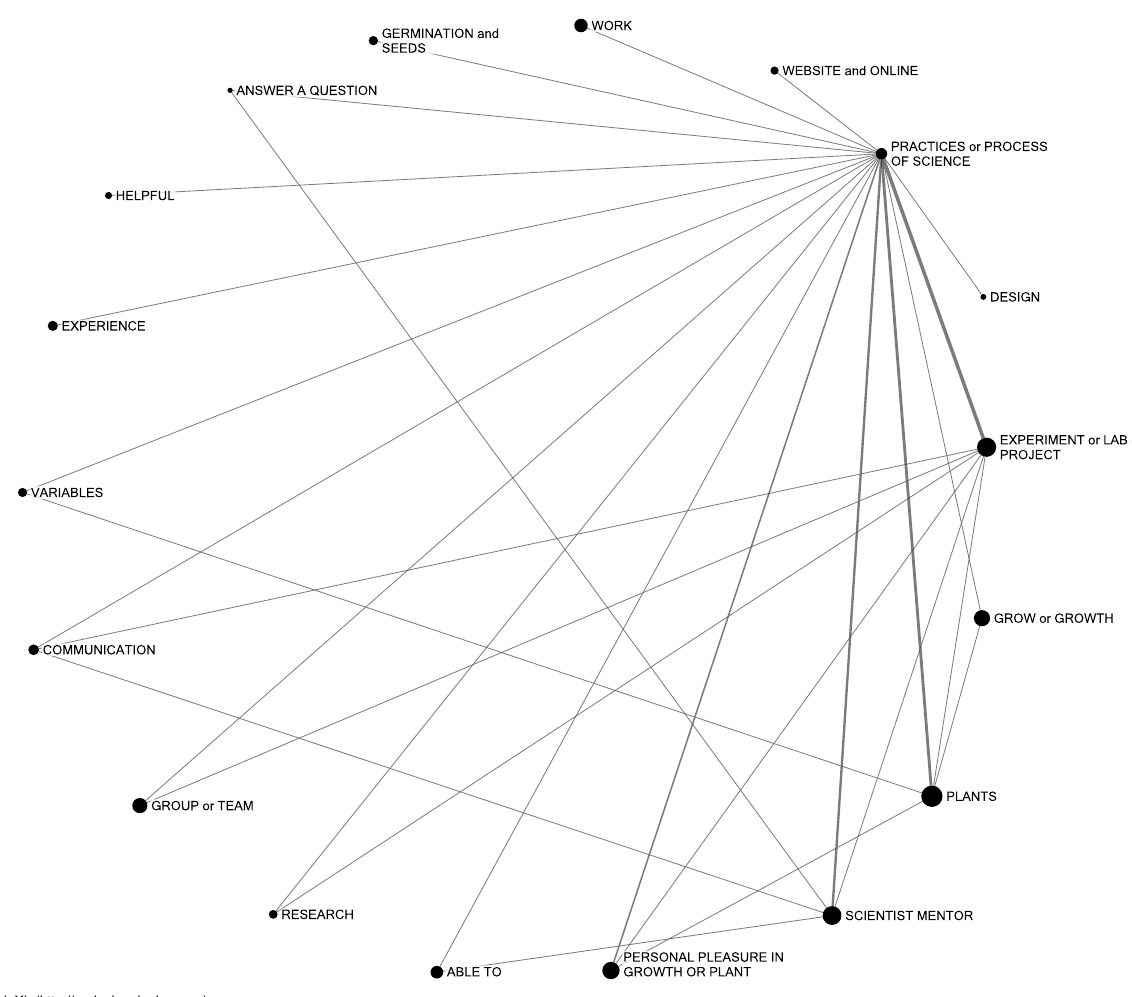
Figure 4. Lexical web illustrating connections of students’ comments about liking the experiment to other favored elements. The size of the node represents the number of total respondents liking that element, and the width of the line between nodes is weighted by the number of shared responses. Items with fewer than 10 respondents are filtered out to simplify the lexical